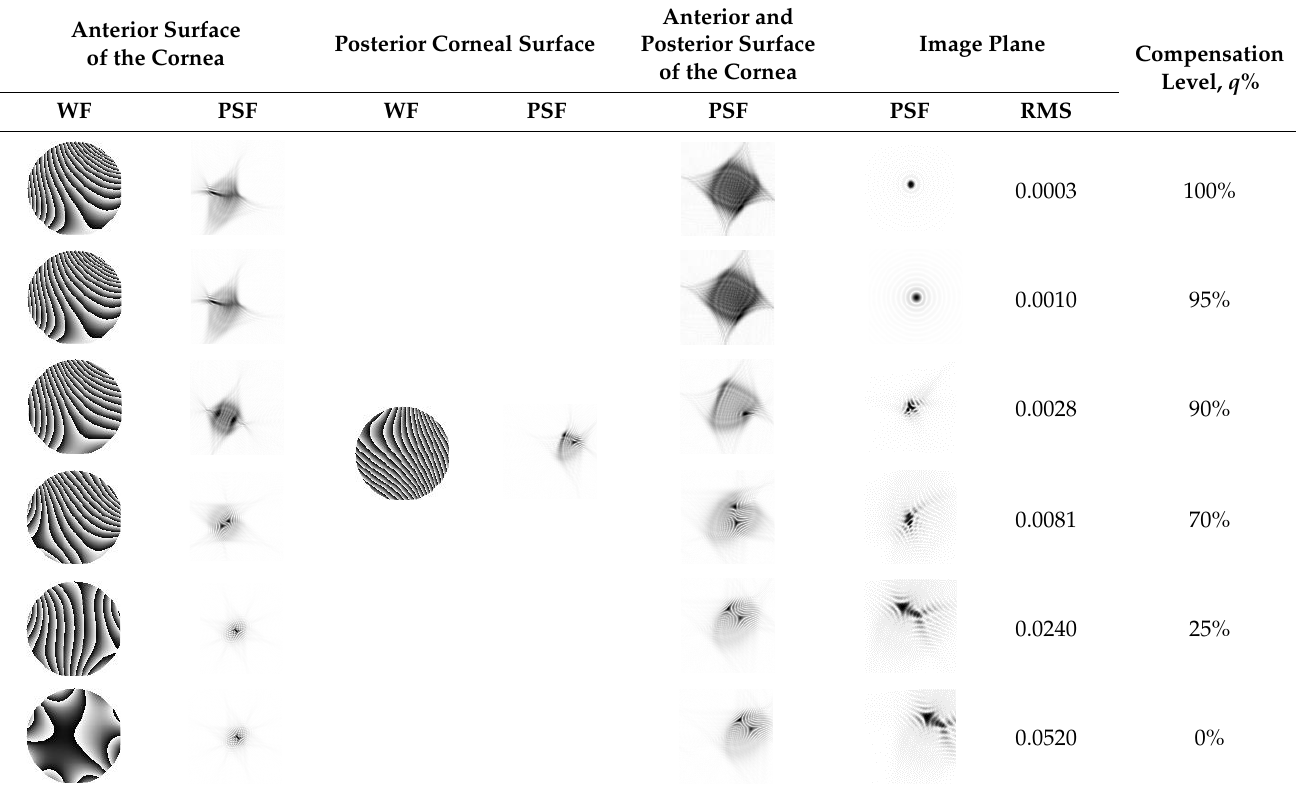
Table 3. Wavefront and corresponding PSF for a cornea with low myopia before and after simulation of aberration compensation with a deviation (RMS) from the reference model by more than s %.